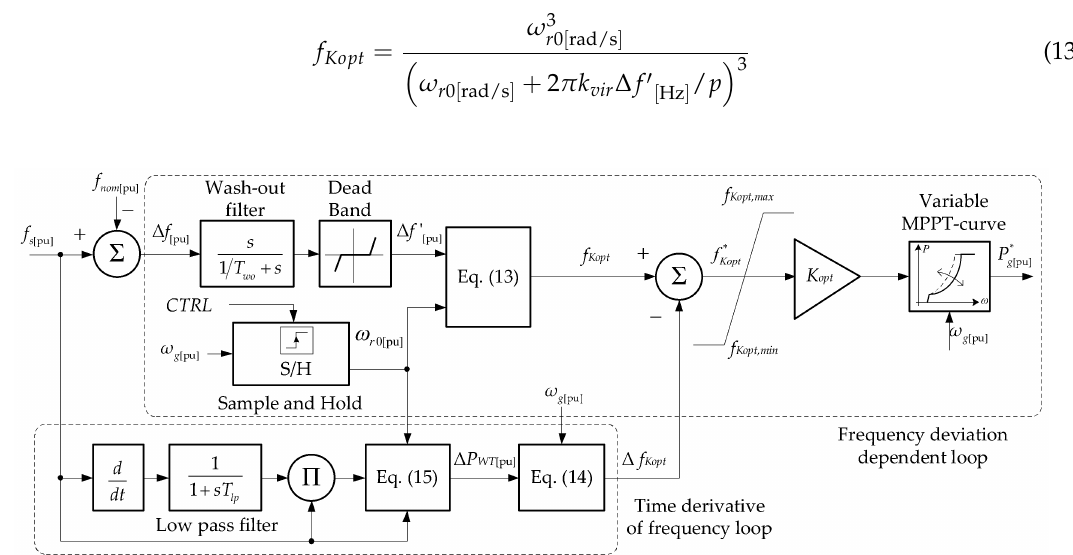
Figure 21. Extended Optimal Power Point Tracking method